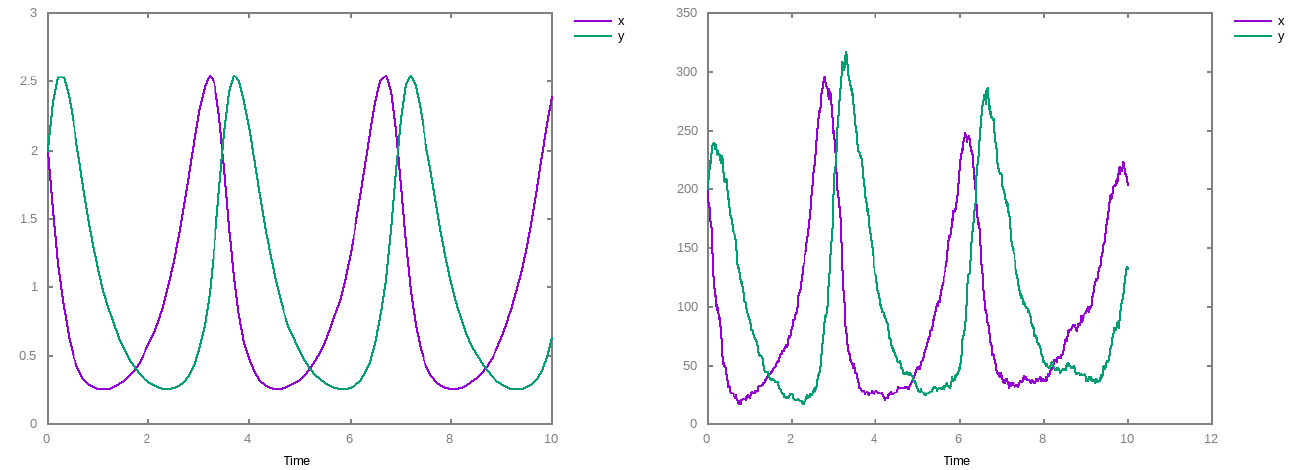
Figure 2. Simulation of the predator–prey model. ( Left ) deterministic. ( Right ) SSA; only the average values are shown.